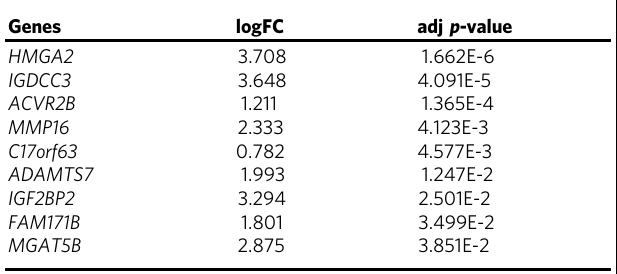
Table 1 Signi fi cantly deregulated genes in DICER1